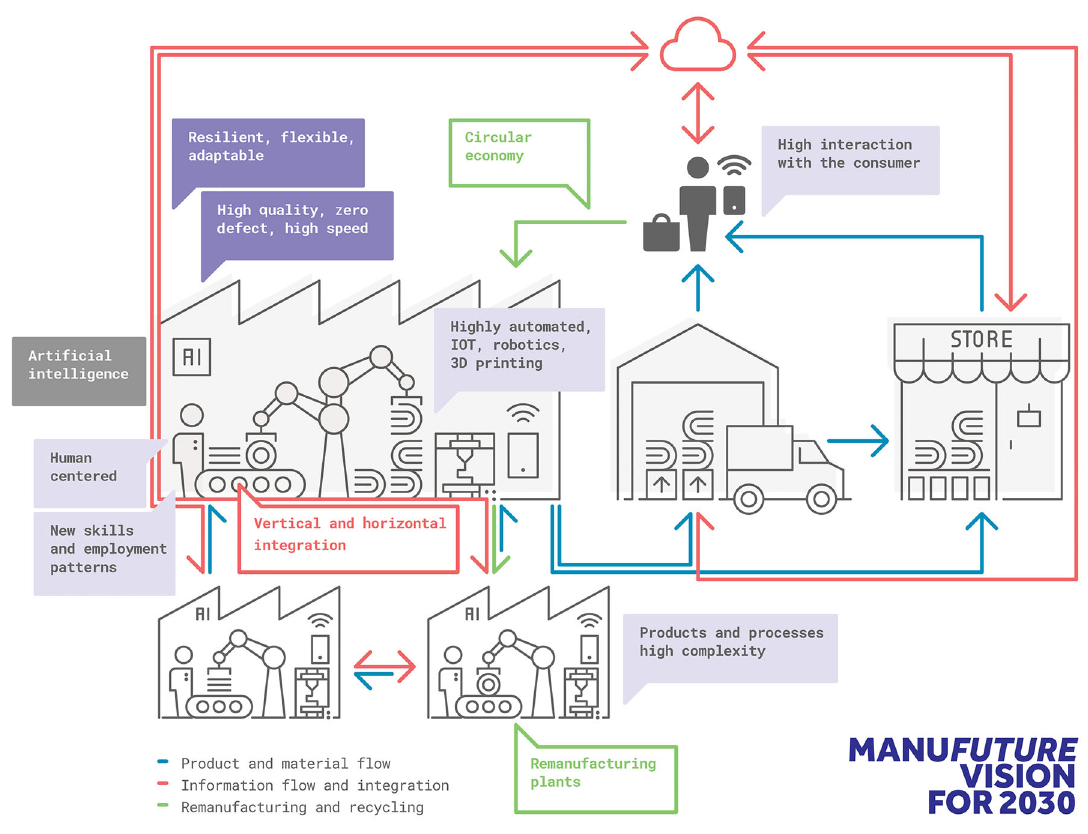
Fig. 1. ManuFuture technology platform vision for